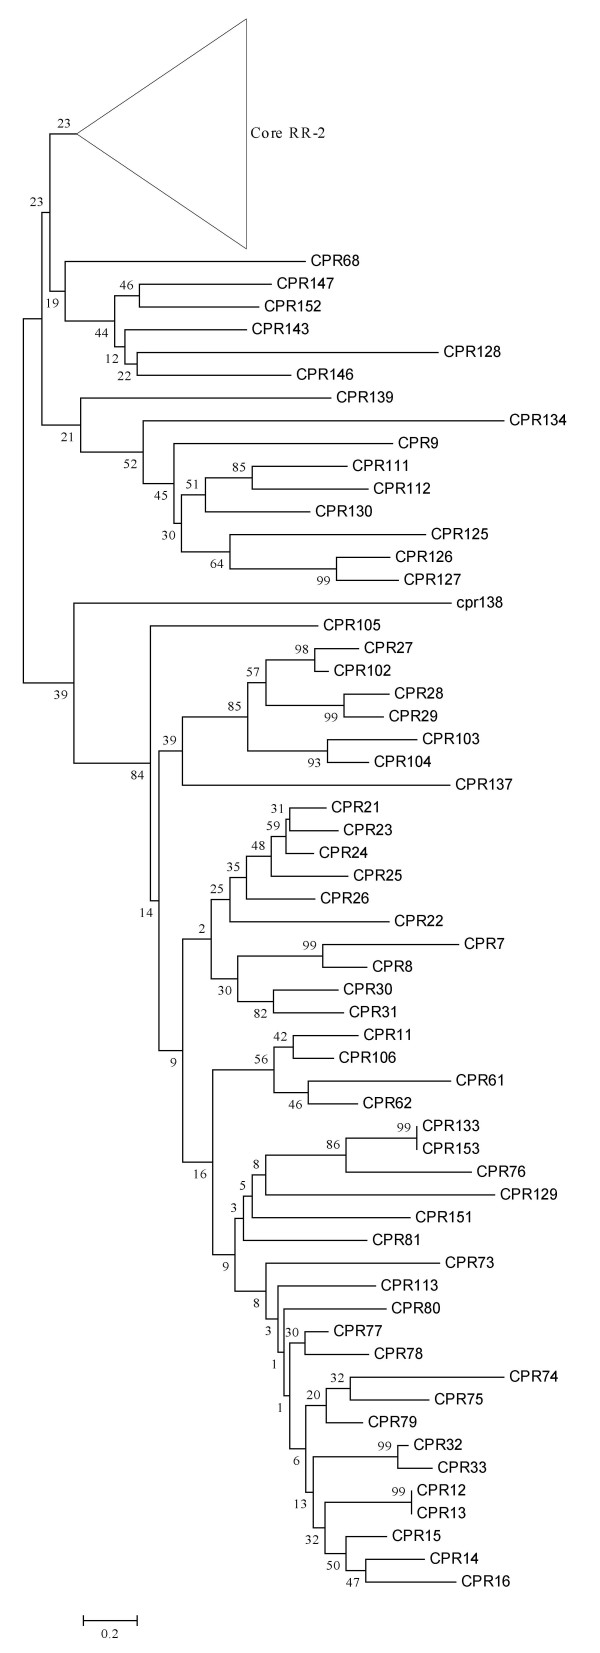
Phylogenetic relationships of the core RR-1 and intermediate CPR proteins. A detailed view of the neighbor-joining tree of An. gambiae CPR genes with the branch leading to the main group of RR-2 proteins shown in Figure 6 collapsed. Numbers at nodes indicate the percentage of 1000 bootstrap replicates that support the node.